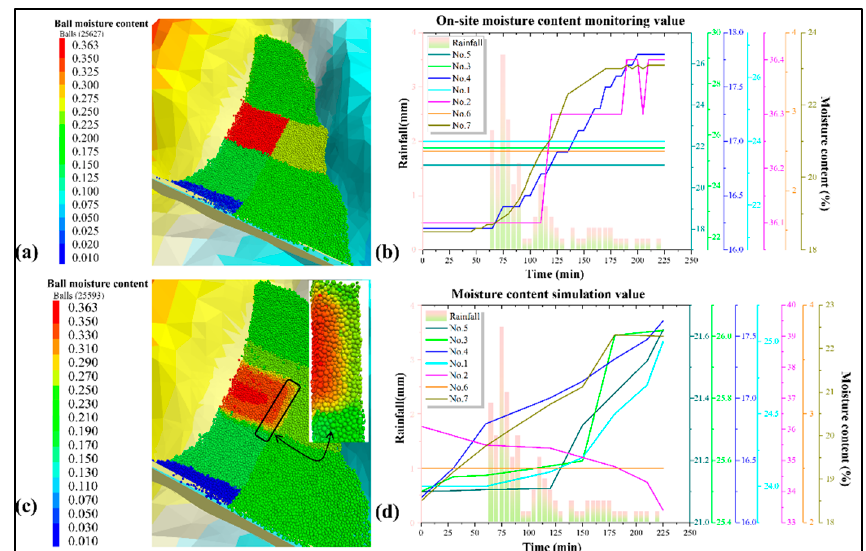
Figure 7. Comparison of field monitoring values and numerical simulation values of seven water content monitoring points. ( a ) Distribution of water content at the initial stage of rainfall; ( b ) Variation in water content on-site during a rainfall event; ( c ) Distribution of water content at the end of rainfall; ( d ) Water content change of numerical simulation during a rainfall event.